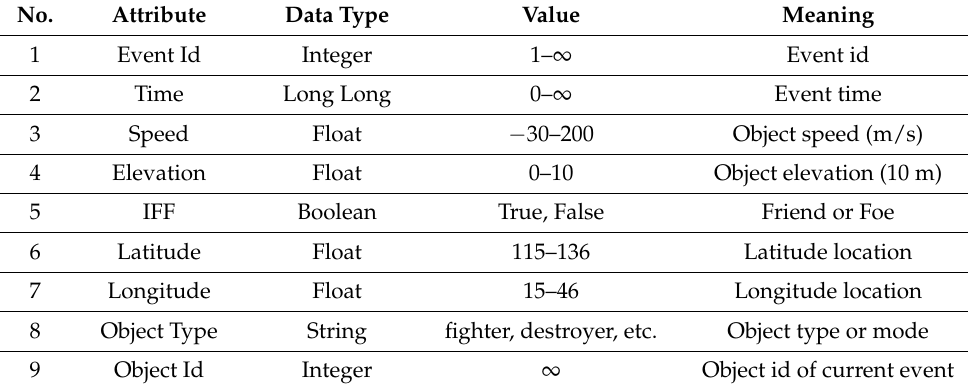
Table 1. Object initialization